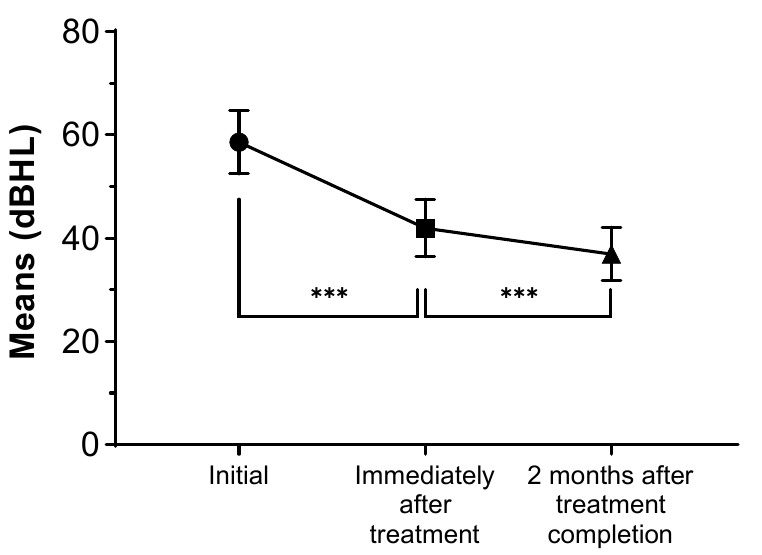
Figure 3. The repeated measures analysis of variance graph of the interaural hearing differences over time. The results are represented as the mean, and the vertical bars denote 95% confidence intervals. *** p -value less than 0.001.